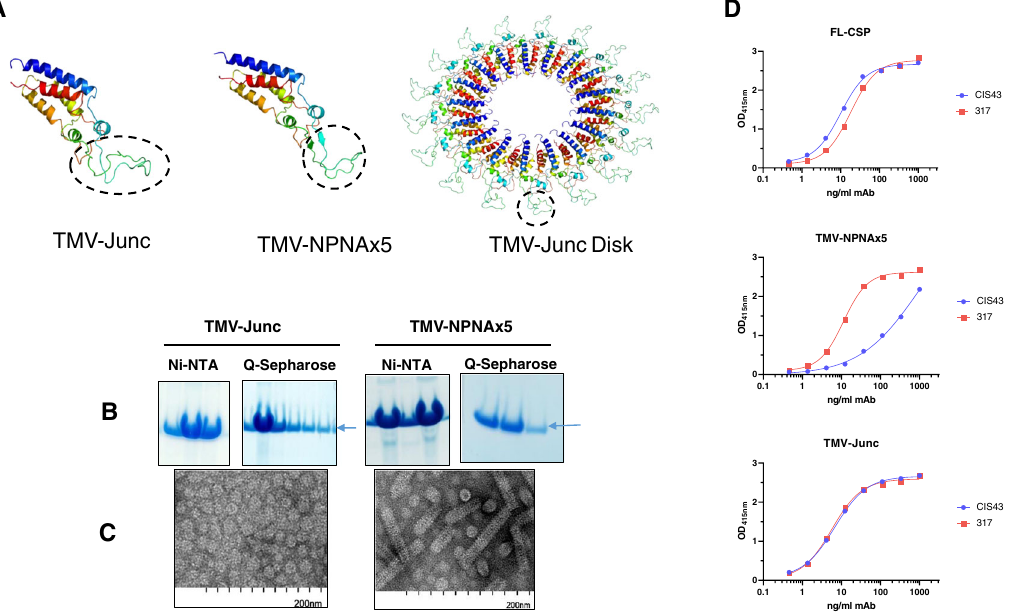
Fig. 1 Design and characterization of TMV-based constructs used in Study 1. A Predicted monomer structures of circular permutants with inserted epitopes (circled). Left (TMV-Junc); middle (TMV-NPNAx5); and right (fully assembled TMV-Junc disk based on 3KML crystal structure). All structures were predicted by Rosetta Protein Prediction Server and images generated using PyMOL software. B Coomassie blue stained SDS-PAGE gels showing Ni-NTA and Q-Sepharose puri fi cation results for TMV-Junc and TMV-NPNAx5 proteins (arrow). C Electron micrographs of each puri fi ed vaccine preparation. D Representative ELISA titration curve of mAbs 317 (red) and CIS43 (blue) binding to FL-CSP, TMV- NPNAx5, and TMV-Junc (top to bottom).